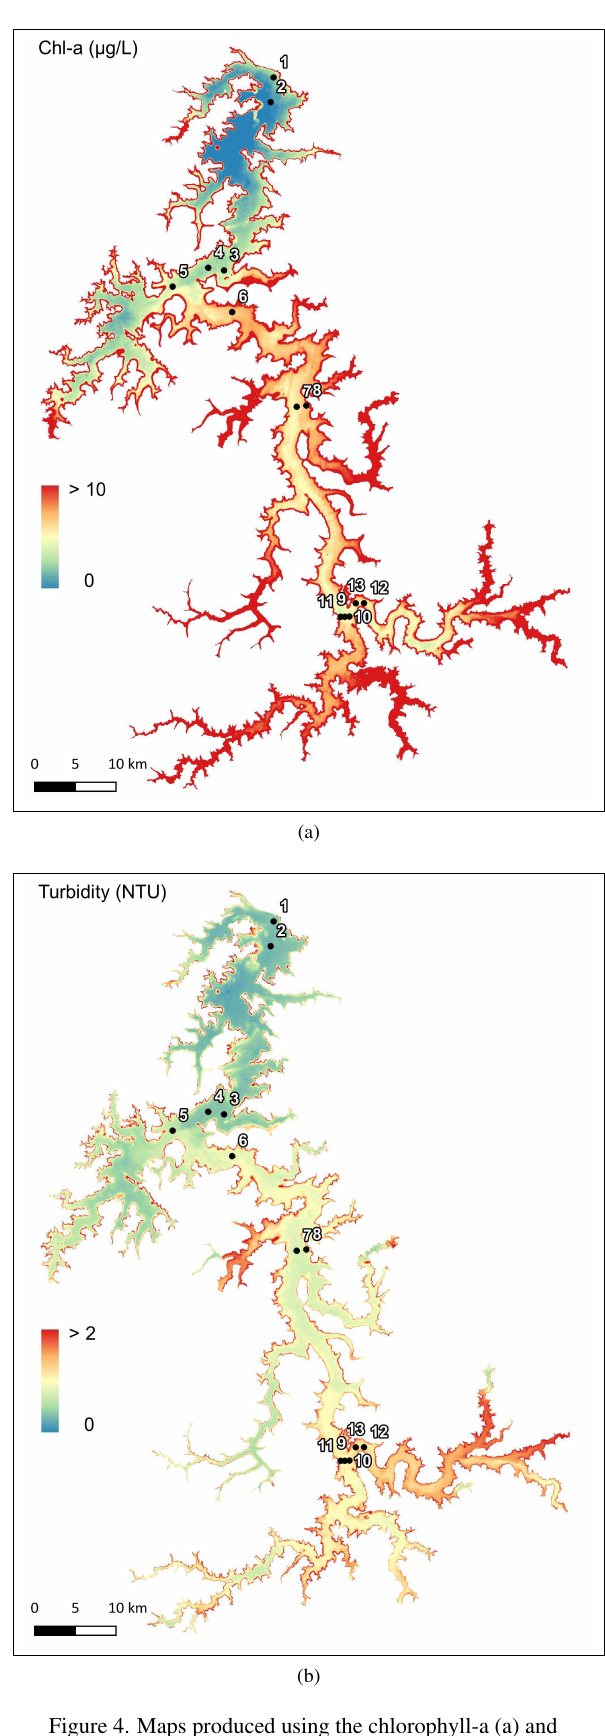
Figure 4. Maps produced using the chlorophyll-a (a) and turbidity (b) models for the Landsat-8 OLI